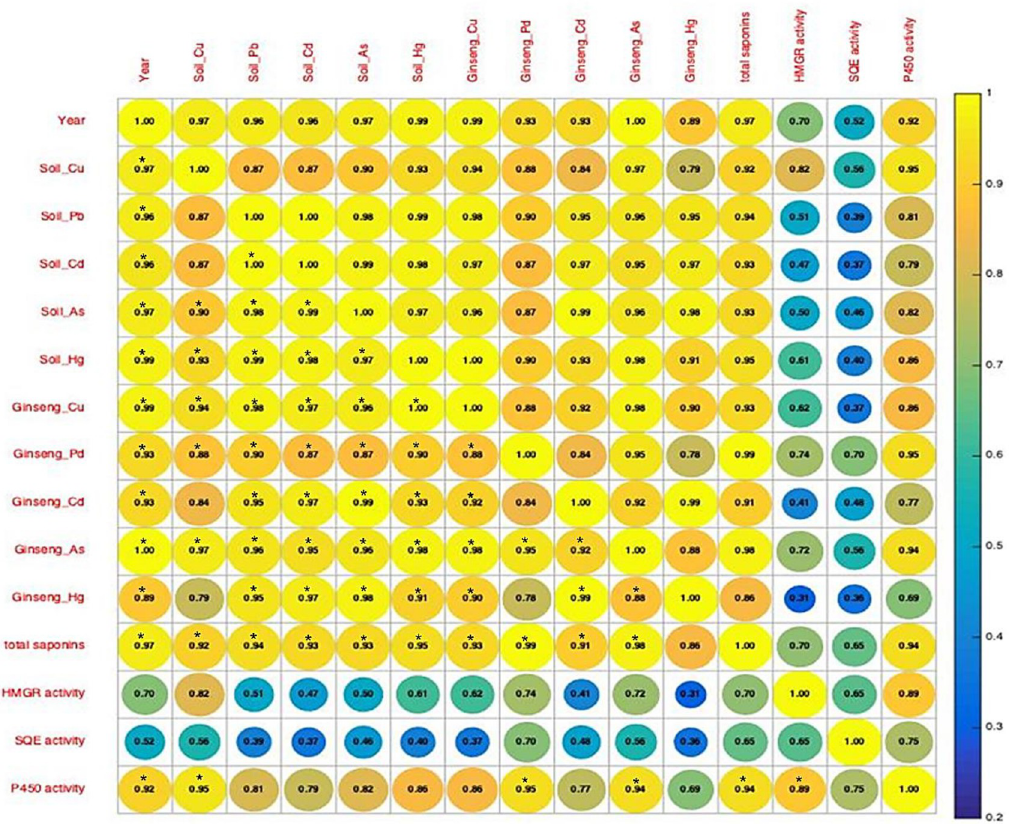
Fig 4. Correlation between ginsenosides content, heavy metal content and enzyme activity in ginseng over time. Colors and Numbers represent the strength of the correlation. � represents P at the 0.05 level.